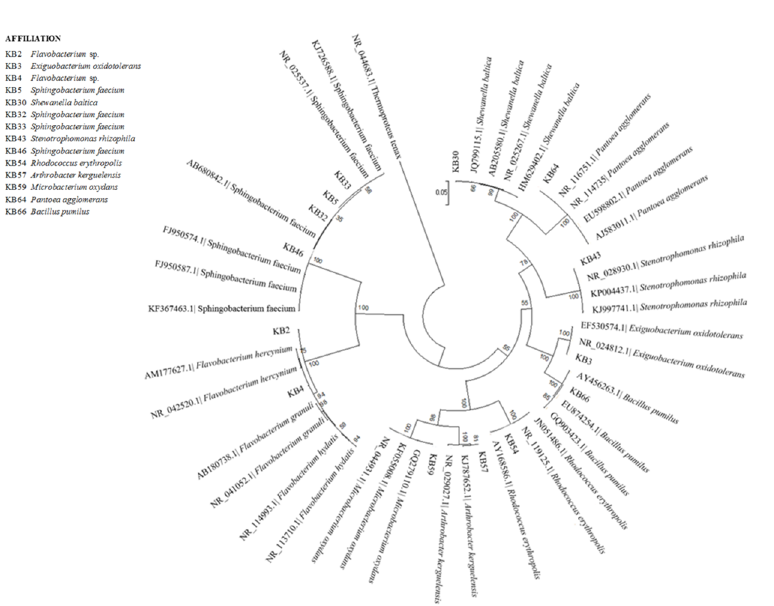
Fig 4. Maximum Likelihood phylogenetic dendrograms of KB strains belonged to the “Other” group, based on 16S rDNA sequences. Bootstrap values calculatedfor 1000 replications(values lower than 50 are not shown). Bar, 5 nt substitution per 100 nt.